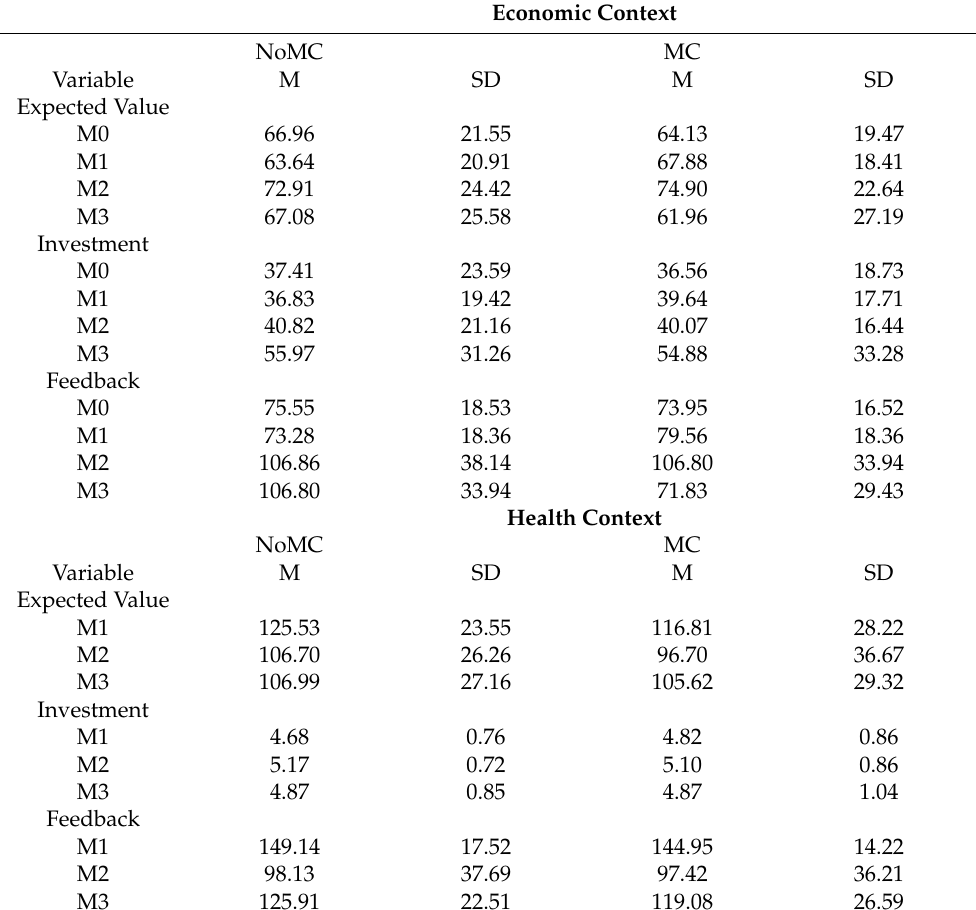
Table 2. Descriptive statistics, using the experimental outcome variables for either economic or health contexts in both groups (No-MC, no metabolic control achieved; MC–successful metabolic control). These are sorted in terms of expected value, investment and feedback